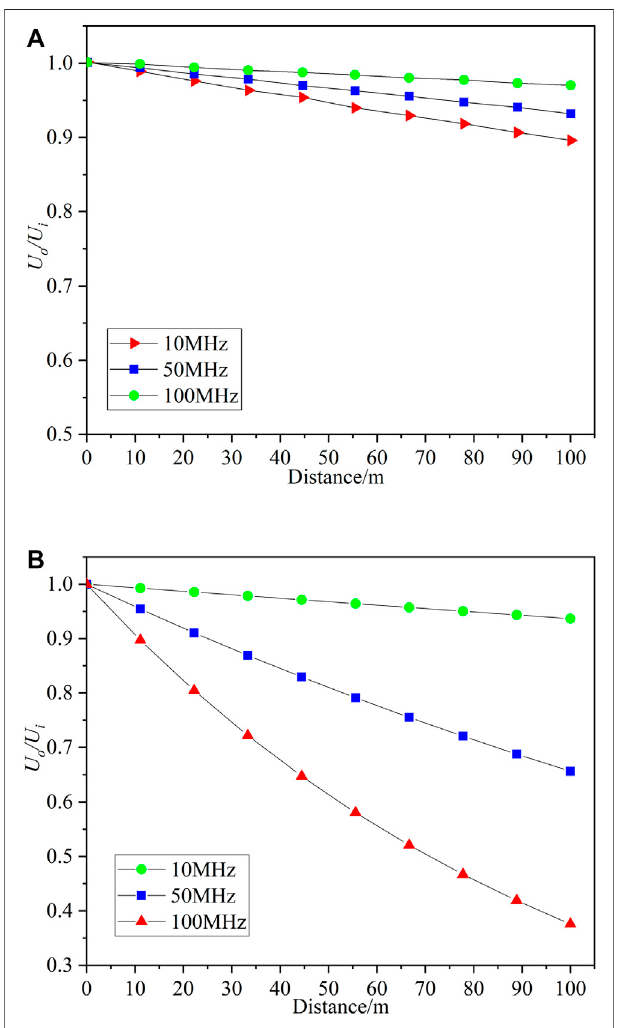
FIGURE 3 | Variation of transmission attenuation of signal amplitude at different frequencies with axial distance of high-voltage cable. (A) Without semi-conductive layer. (B) With semi-conductive